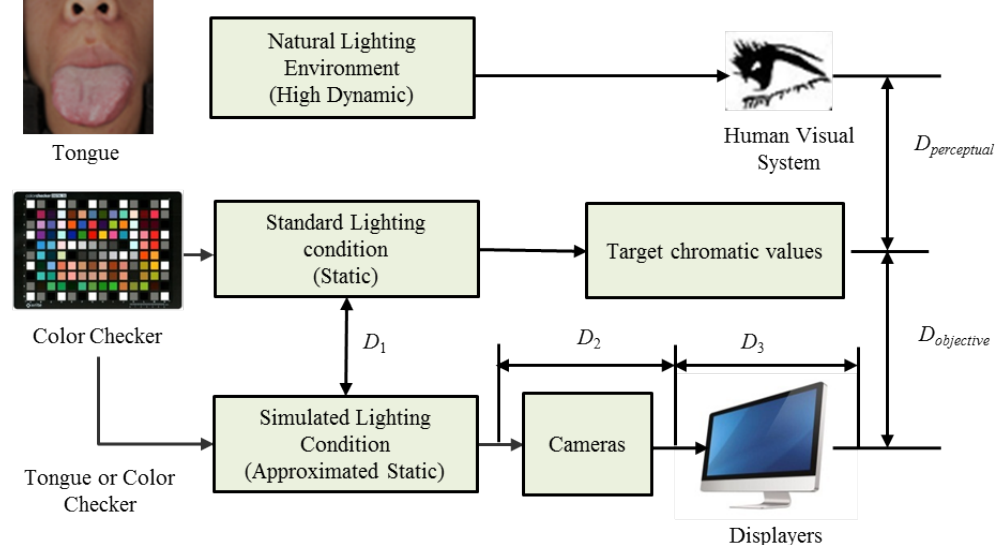
Figure 1. Color distortions in the procedure of tongue images acquisition. We formulate the color distortion as the sum of an objective distortion ( D objective ) and a perceptual distortion ( D perceptual